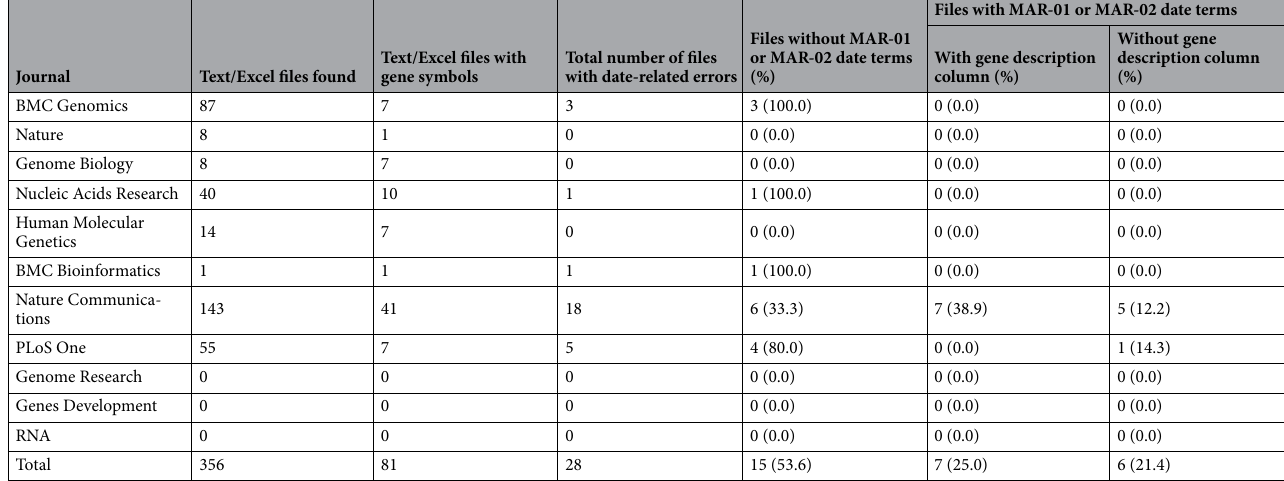
Table 2. Journals publishing text or Excel files with date-related errors in June 2022. Number of files with and without MAR-01/MAR-02 genes are indicated, and the respective percentages presented in parentheses.